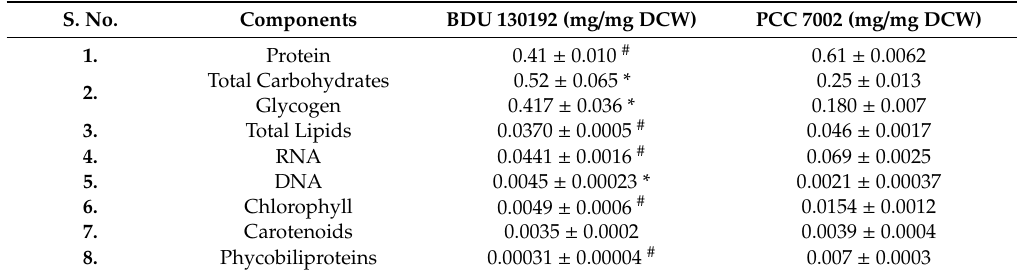
Table 1. Biomass compositions of Synechococcus sp. BDU 130192 and Synechococcus sp. PCC 7002.